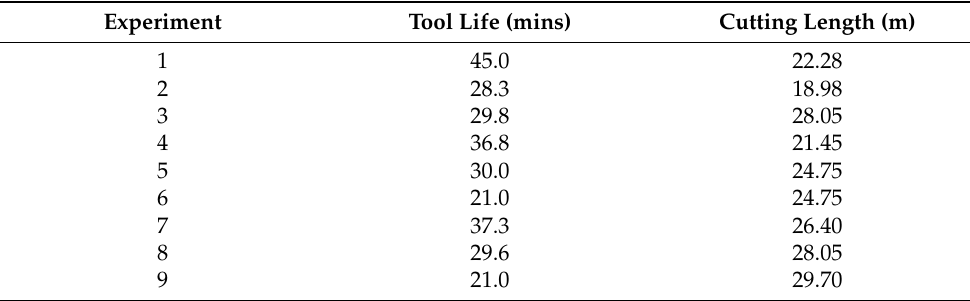
Table 5. Tool life and cutting length of multilayer coated carbide cutting tools.